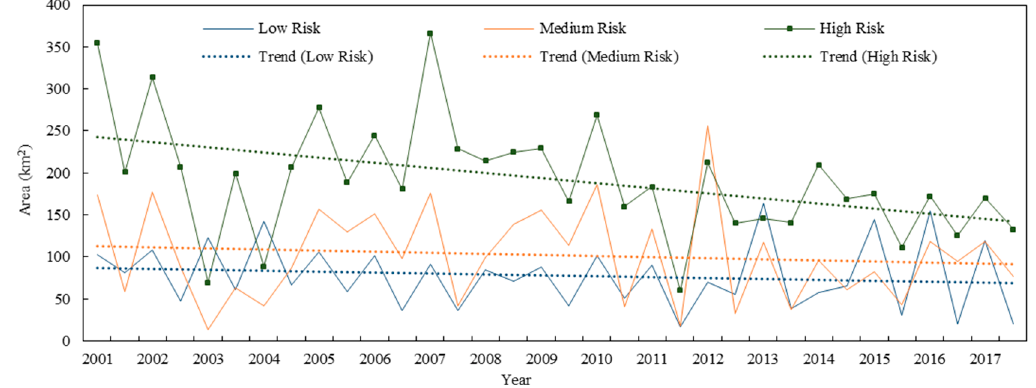
Figure 12. Variation trends of the areas of different algal bloom risk levels during summer and autumn from 2001–2017.